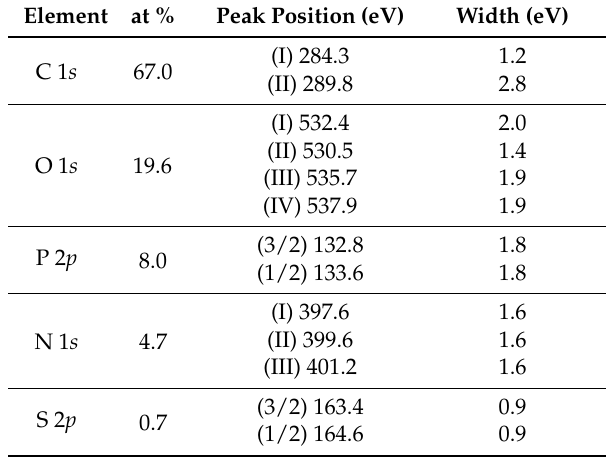
Table 1. Atomic percentage, peak position and width obtained by fitting the high resolution XPS spectra.